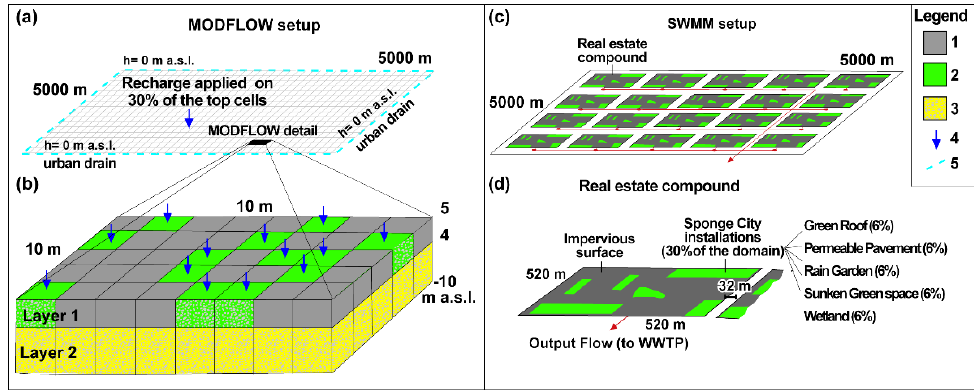
Figure 3. MODFLOW model setup of the domain ( a ) and detail ( b ). Key to the legend: impervious urban infrastructures (1); Sponge City installations recharging the aquifer (2); urban aquifer (3); flow recharging the aquifers, 30% of the top cells (4); urban drain, h = 0 m a.s.l. (5). SWMM setup throughout the entire domain ( c ) and detail of the real estate compound ( d ). It is assumed that each compound is equally covered by green roofs, permeable pavements, rain gardens, sunken green spaces, and wetlands, covering 30% of the domain. Table 1. Hydraulic conductivity and specific yield of the materials used for MODFLOW models. Simulations are repeated five times, varying the soil properties of the underlying urban